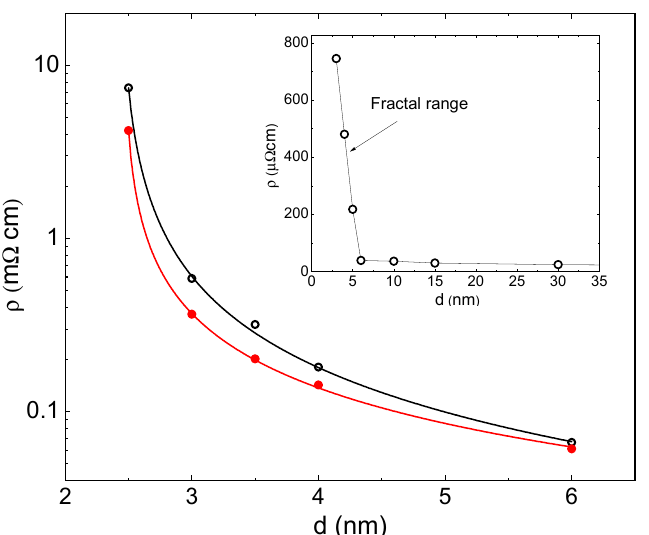
Figure 3. Resistivity of Pd films as a function of thickness prior (open circles) and after (solid circles) hydrogen loading. Solid lines in the main frame fit to Equation (2): ρ ( d ) = αρ 0 ( d − d c ) − m . d c = 2.4 ± 0.05 nm and m = 1.1 ± 0.1 in both states. Inset: resistivity as a function of thickness prior to hydrogen loading in a linear